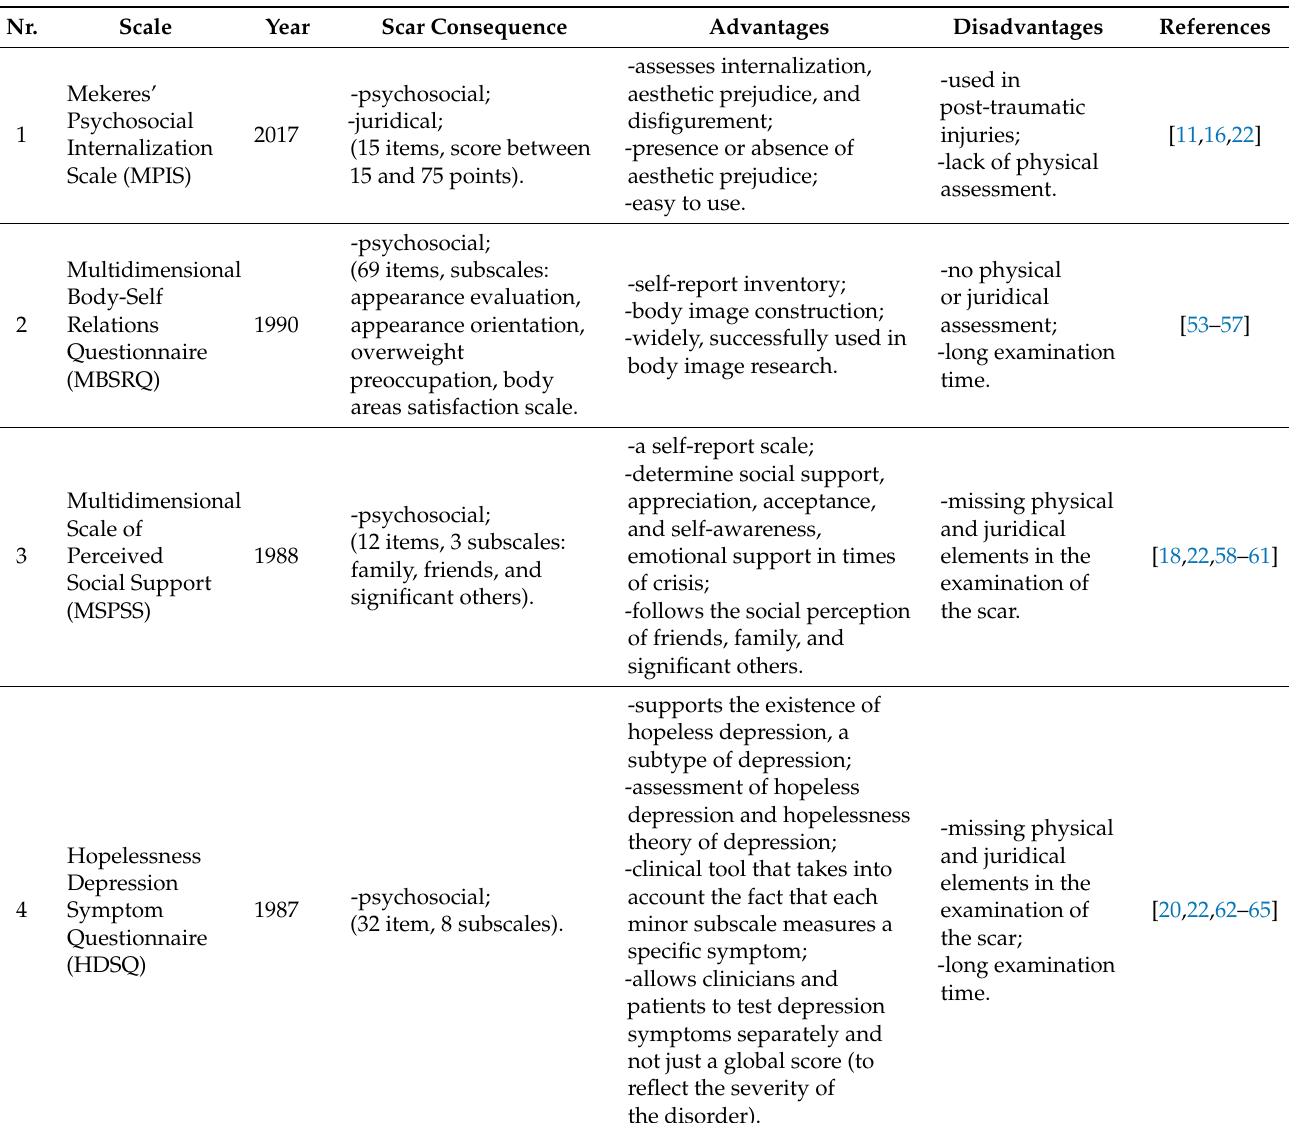
Table 2. Psychometric scales for the assessment of